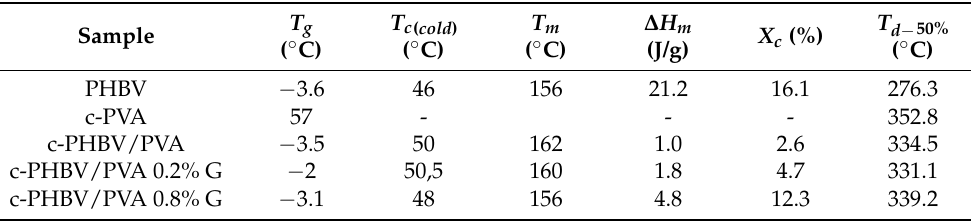
Figure 6. DSC thermograms at a rate of 20 °C/min of c-PHBV/PVA and c-PHBV/PVA with graphene nanosheets (0.2% and 0.8%). Normalized heat flow on heating. Neat PHBV, crosslinked PVA (c-PVA), and G nanosheets are included as reference. Table 2. Glass transition temperature ( T g ), cold crystallization temperature ( T c ( cold ) ), melting temper- ature ( T m ), melting enthalpy ( ∆ H m ), degree of crystallinity ( X c (%)), and decomposition temperature at which weight loss was 50% ( T d − 50%